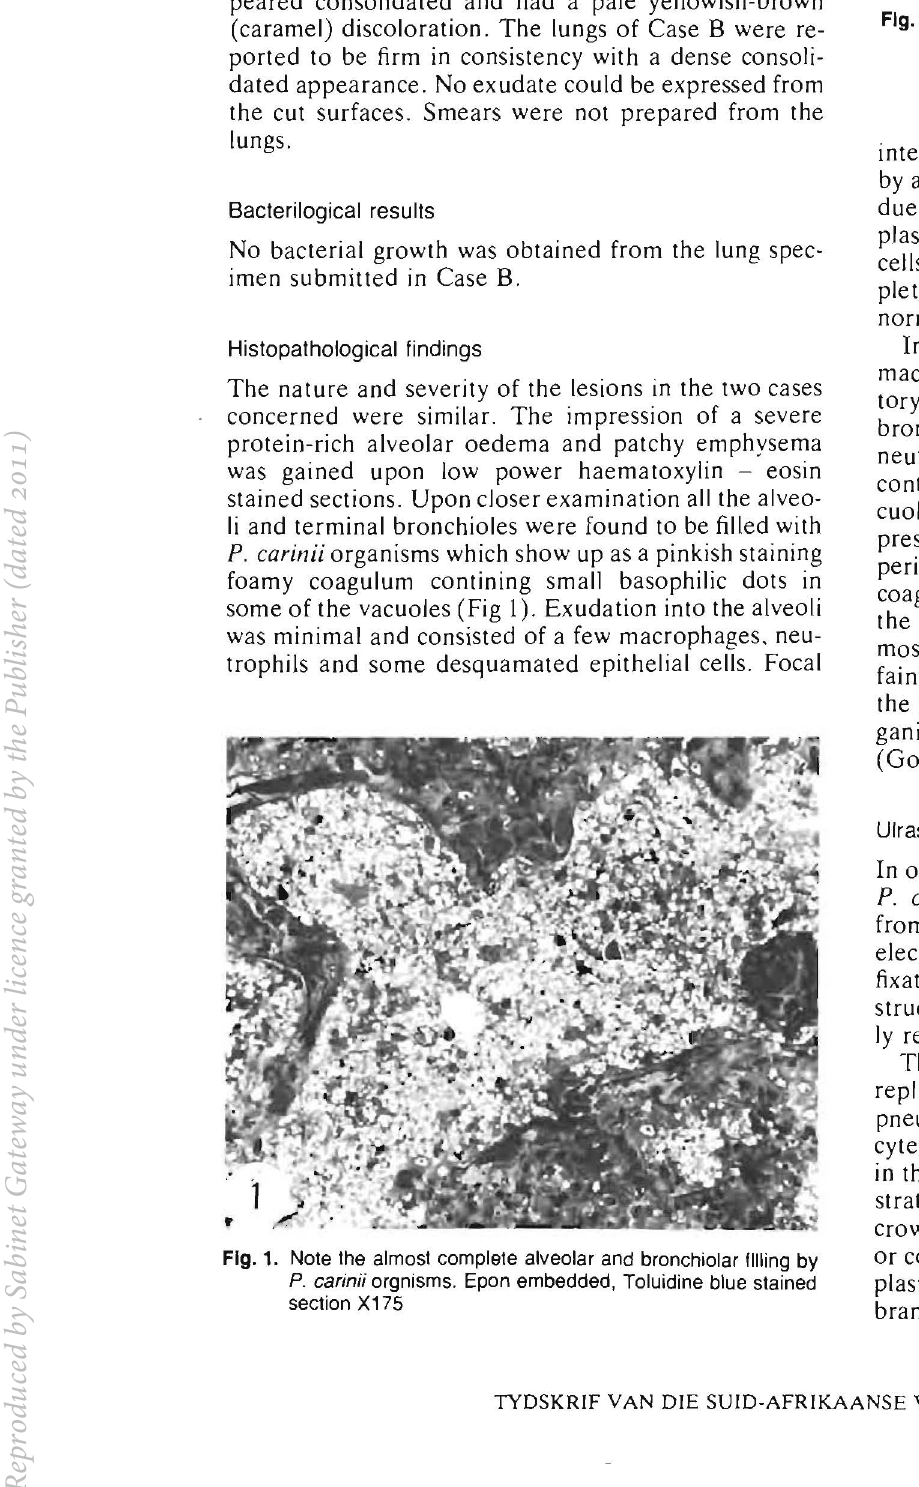
Fig. 2. Alveolar filling by pneumocysts. Two neutrophils are indio cated by arrows. Epon embedded, Toluidine stained section